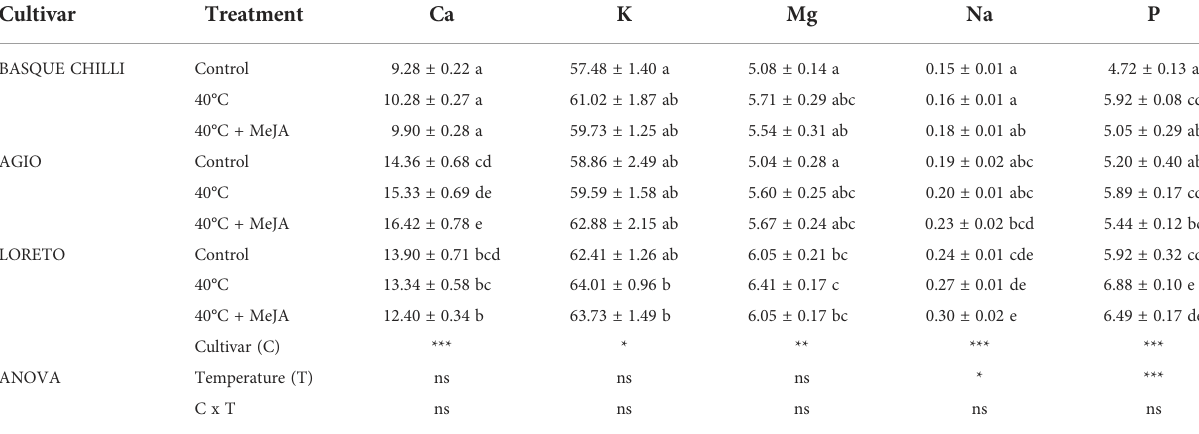
TABLE 2 Effects of heat shock and MeJA on leaf cation concentration (g kg -1 DW) of the three pepper cultivars.